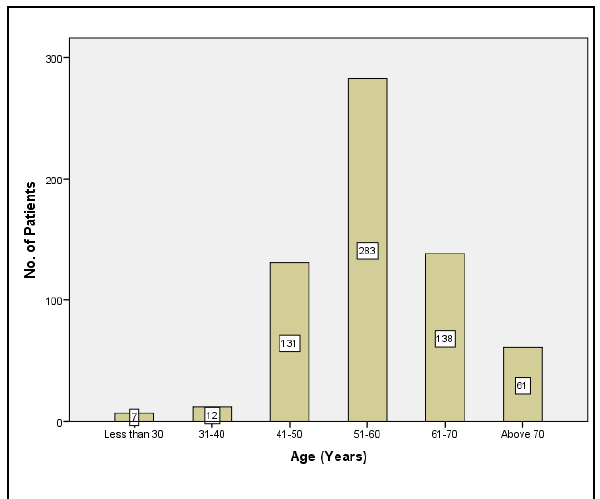
Figure 1: Distribution of patients according to age groups